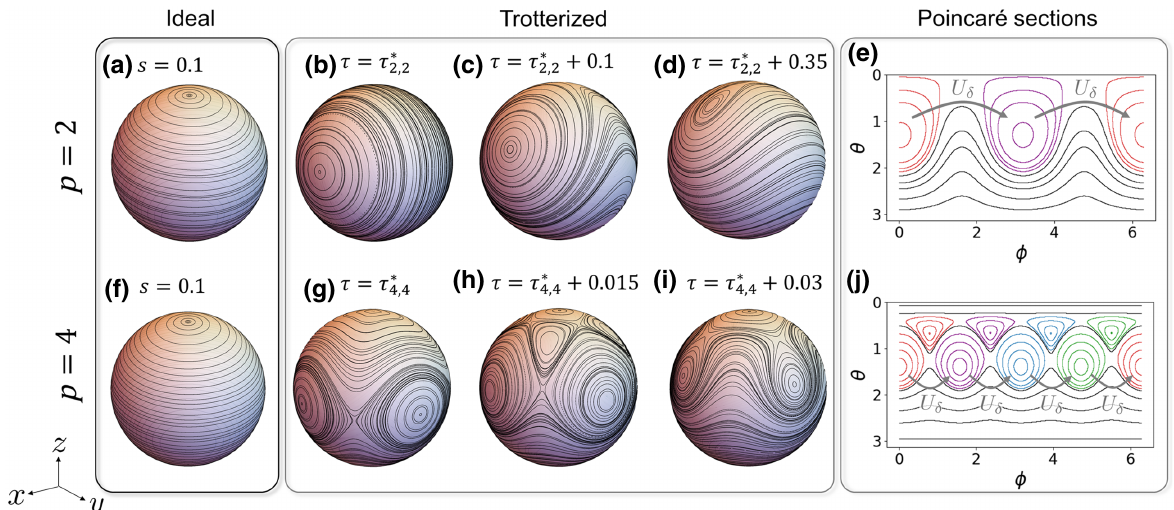
FIG. 3. (a) Classical phase-space trajectories associated with the mean-field dynamics of the target unitary map for p = 2 (LMG model) at s = 0.1. (b)–(d) Classical phase space associated with the Trotterized unitary for p = 2 at s = 0.1 for various Trotter step = π/ 0.9. The phase-space trajectories in (b) through (d) show that sizes located in the structural instability region, centered at τ = τ ∗ 2,2 the targeted simulation of the paramagnetic phase dynamics through Trotterization results in simulation of the ferromagnetic phase of . This process is accommodated by a 1-to-2 bifurcation at Z = 1. the LMG model when the Trotter step sizes are chosen around τ ∗ 2,2 (e) Identical to the phase space shown in part (c) but plotted as a function of the polar and azimuthal angles. Parity-broken trajectories are colored red and purple to illustrate that states initialized in the lobed region jump between the red colored curve and the corre- sponding purple colored curve, tracing out two trajectories at the same time. On the other hand, parity-broken trajectories (black color) trace out the actual LMG trajectories. (f) Same as in part (a) except this is for p = 4. (g)–(i) The simulated Hamiltonian is now given = − ( 1 − s ) J (cid:17)τ/((cid:17)τ + τ ∗ ) − ( s / 8 J 3 )( J 4 + J 4 ) , and the point Z = 1 has two separate 1-to-4 bifurcations in the instability by H ( 4,4 ) z x y eff region for (cid:17)τ > 0. (j) Phase space shown in part (h) is plotted as a function of the polar and azimuthal angles. As a result of 1-to-4 bifurcations, a state initialized in one of the lobes jumps between different lobes colored red, purple, blue, and green and traces out four different trajectories (one in each